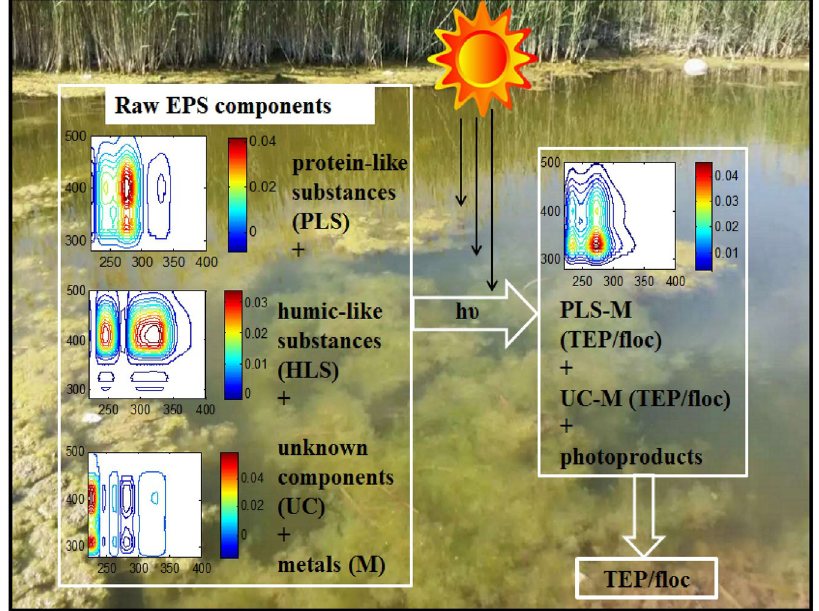
Figure 7. A conceptual model of TEP/floc formation from raw EPS components. Where PLS, HLS and UC are the protein-like substances, humic-like substances, unknown components and their complexes with metals are PLS-M, HLS-M and UC-M, respectively. Photo-flocculation could occur simultaneously along with photoinduced EPS (or DOM) in aqueous media, thereby forming complexes between free metals and newly formed DOM (photoproducts) that ultimately generate TEPs/flocs. During the end of the processes, humic-like substances are completely decomposed, and their ability to form floc/TEP is decreased. Protein-like substances of EPS predominantly participate in TEP/flocculation